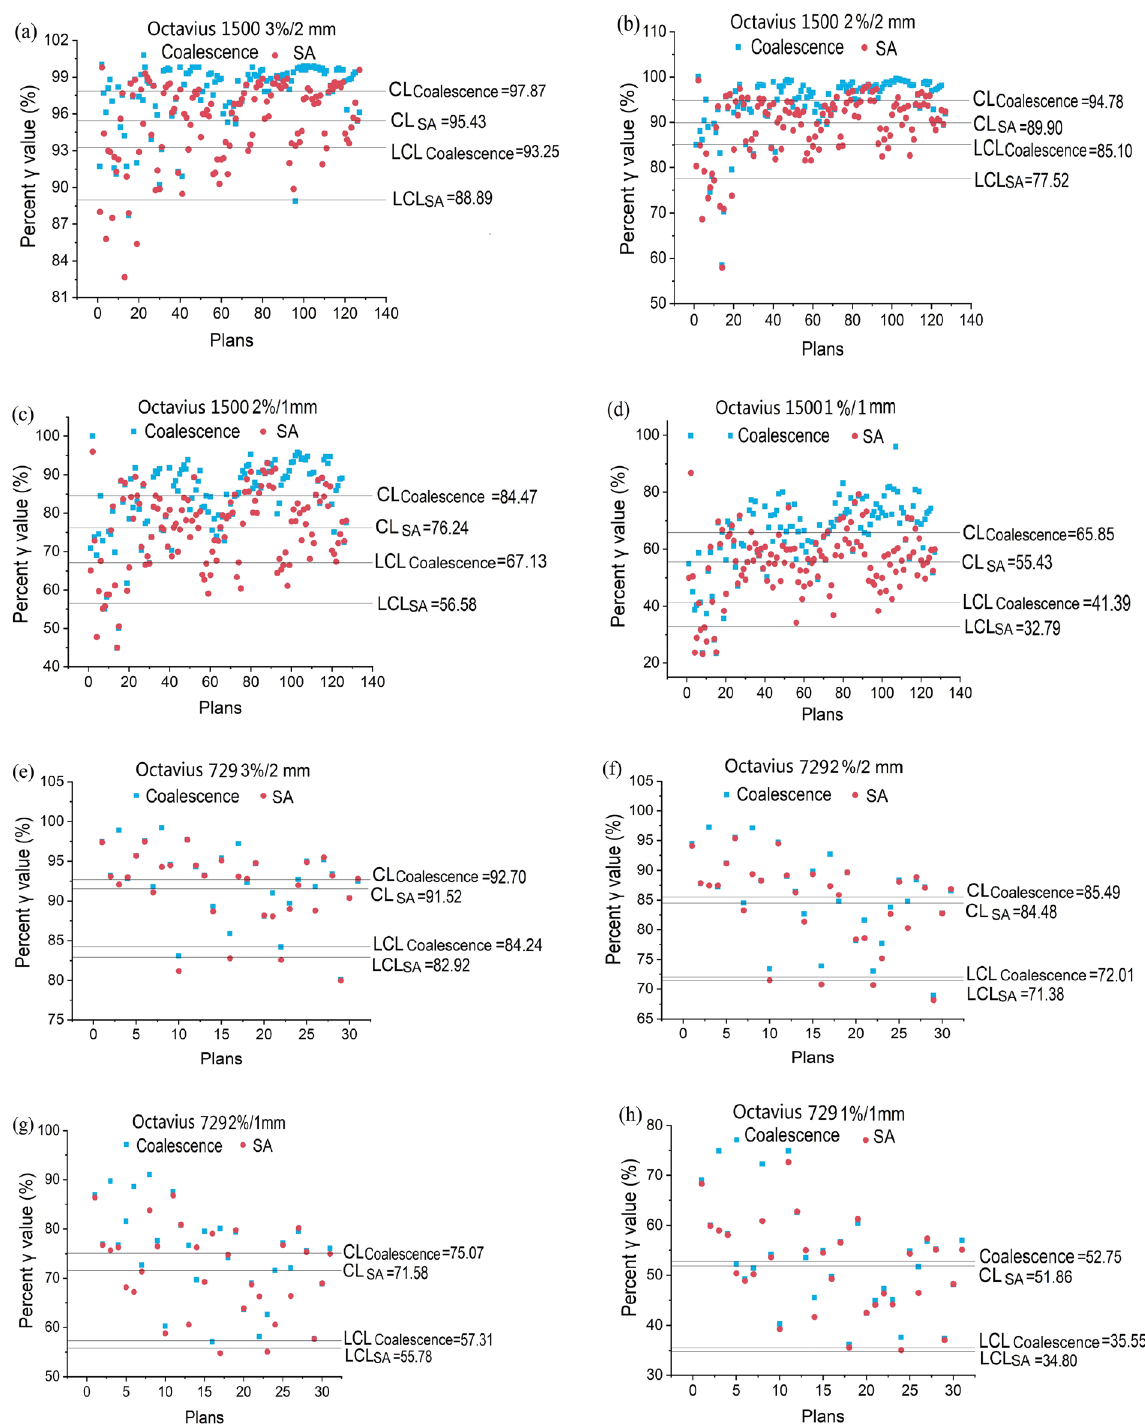
Figure 6. Individual control charts of percent γ values in VMAT QA processes at four acceptance criteria. The central line was represented by the average of a group of data. (a–h) γ values in coalescence and SA cohorts for both detectors, respectively. The arbitrary plan number for each dose-map was listed on x-axis. The differences between CL and LCL in coalesced scenarios were smaller than in SA scenarios. CL center line, LCL lower control